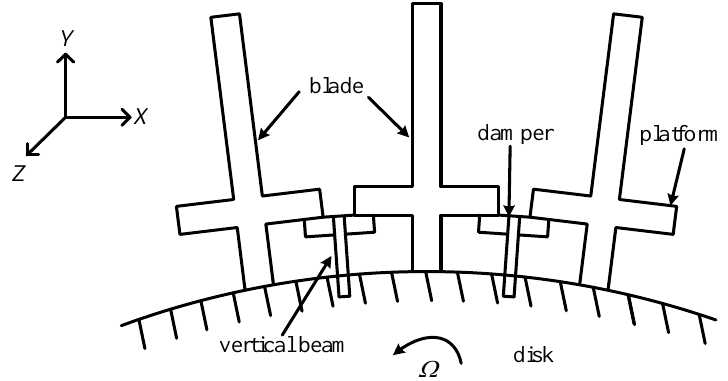
Figure 2. The structural model of the blades with under-platform dry friction dampers.